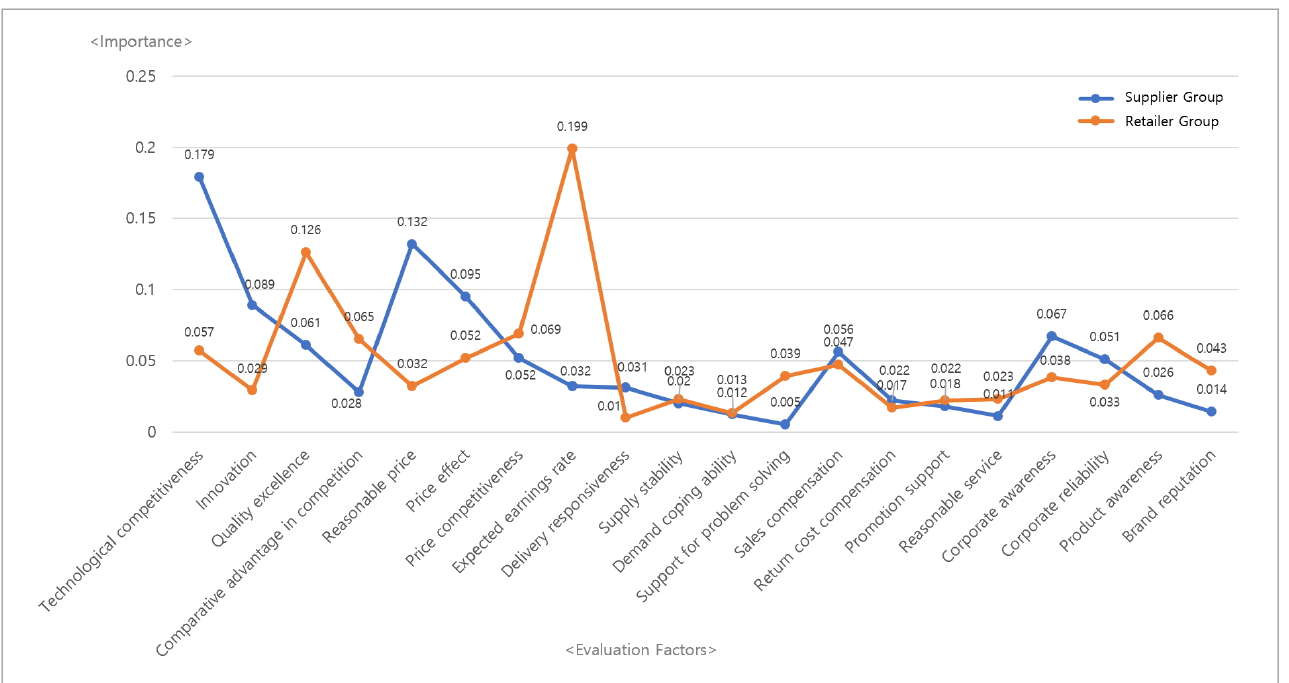
Figure 5. Comparison analysis result of evaluation factors.